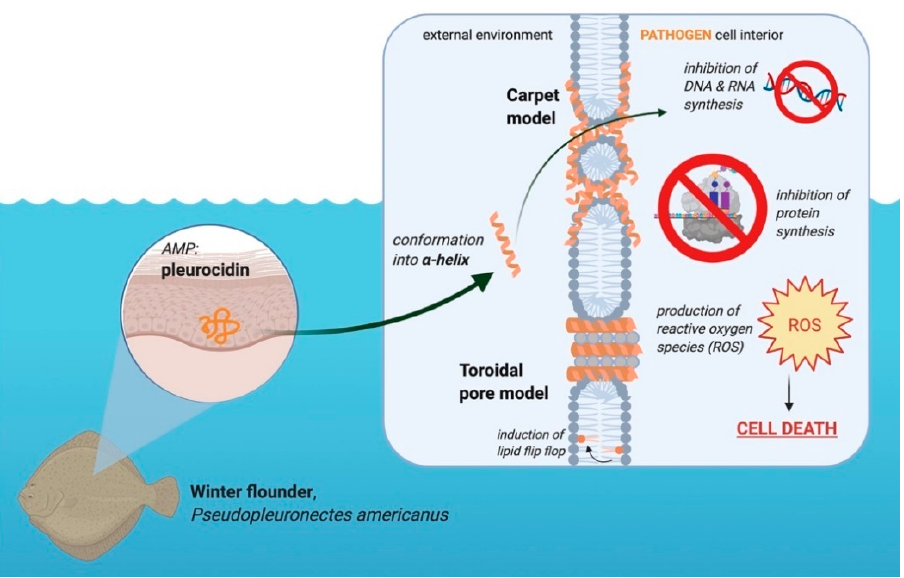
Figure 3. Role of the AMP pleurocidin in the winter flounder in the defense against pathogens. This peptide is located in the granular cells of winter flounder skin. Upon interacting with a negatively charged membrane, the peptide conforms into an α -helix. Made in © BioRender—biorender.com accessed on 31 May 2021.